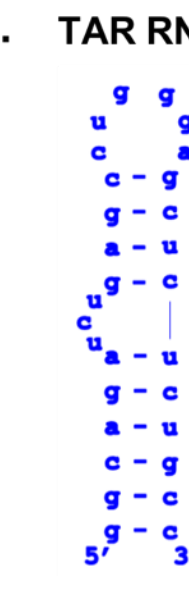
Figure 1. ( A ) Sequence of the full length NC protein. ( B ) Sequence and secondary structure of the TAR construct employed in this study.